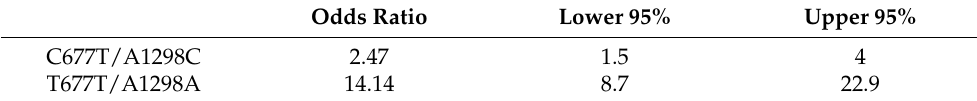
homocysteine. Table 2. Odd ratios of the two main isoform combinations that significantly increase circulating